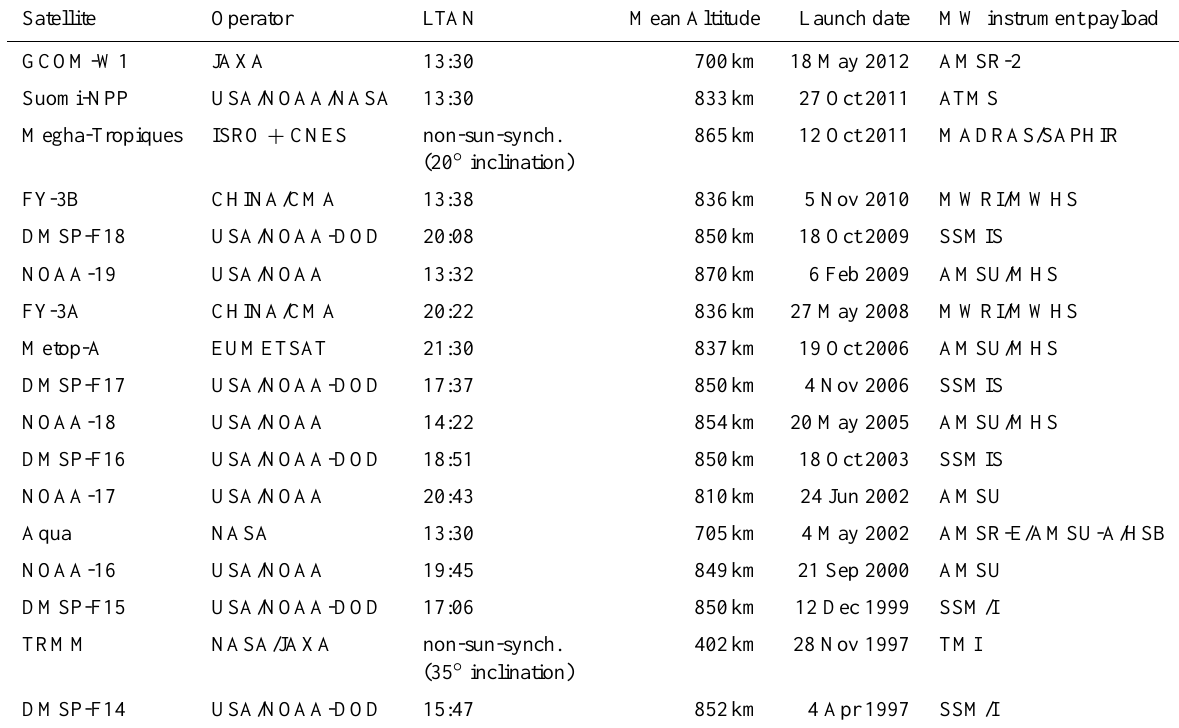
Table 1. List of the main LEO satellites carrying MW radiometers.